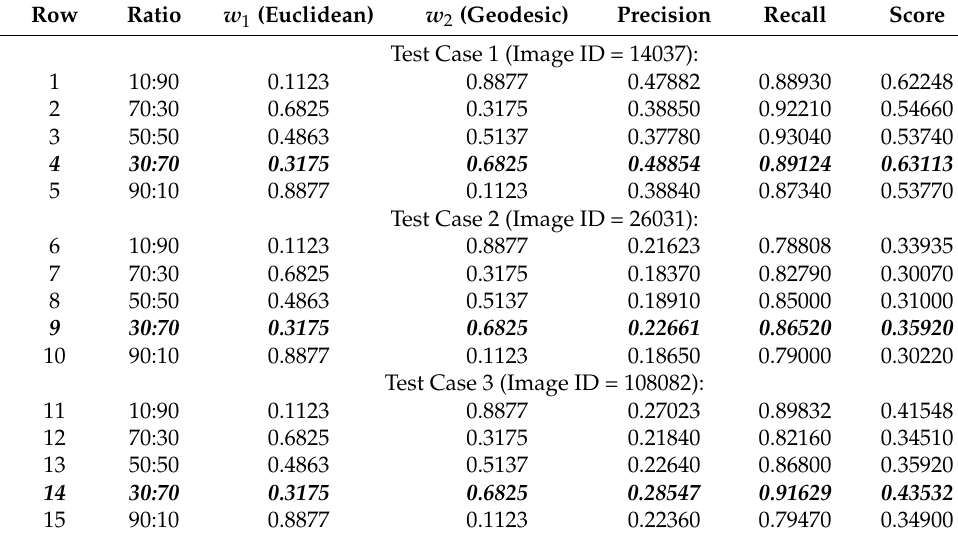
Table 2. Summary statistics of average performance of SLIC++ for varying